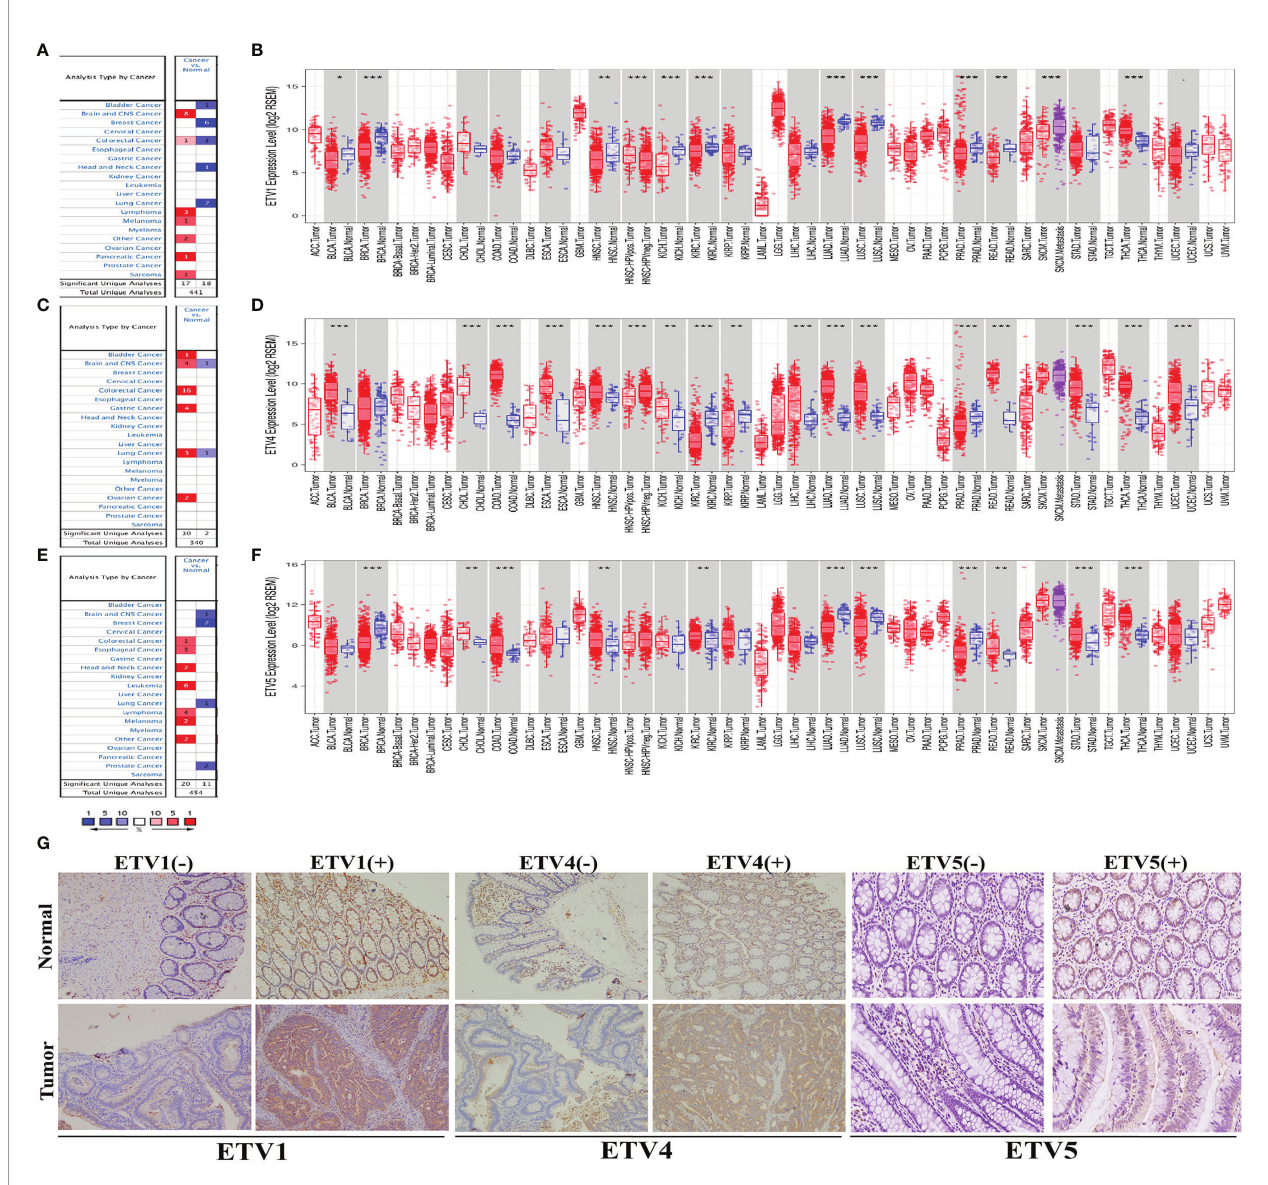
FIGURE 1 | The expression level of PEA3 members in different types of human cancer. (A) Upregulation of ETV1 in 7 cancer types in the Oncomine database. (B) Human ETV1 expression levels in different tumor types from TCGA database were determined by TIMER. (C) Upregulation of ETV4 in 6 cancer types in the Oncomine database. (D) Human ETV4 expression levels in different tumor types from TCGA database were determined by TIMER. (E) Upregulation of ETV5 in 7 cancer types in the Oncomine database. (F) Human ETV5 expression levels in different tumor types from TCGA database were determined by TIMER. (G) Representative images of ETV1, ETV4, and ETV5 immunohistochemistry in CRC and matched normal tissue from the 75 clinical CRC cases. *p < 0.05; **p < 0.01; ***p <